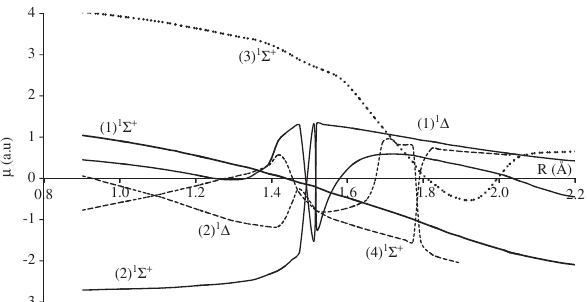
Figure 5: Dipole moment curves of the electronic states 1 Σ ± and 1 Δ of the molecule BF.